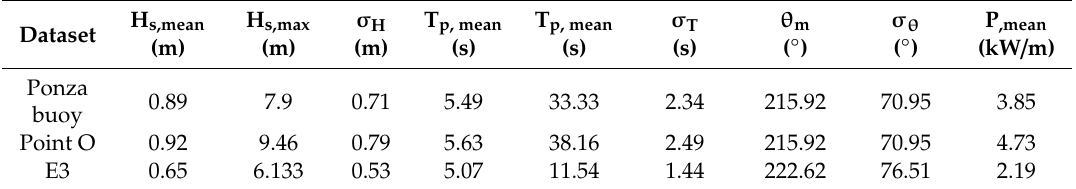
Table 2. Main wave climate parameters (based on the whole datasets) at Ponza wave buoy, point O and ECMWF grid point